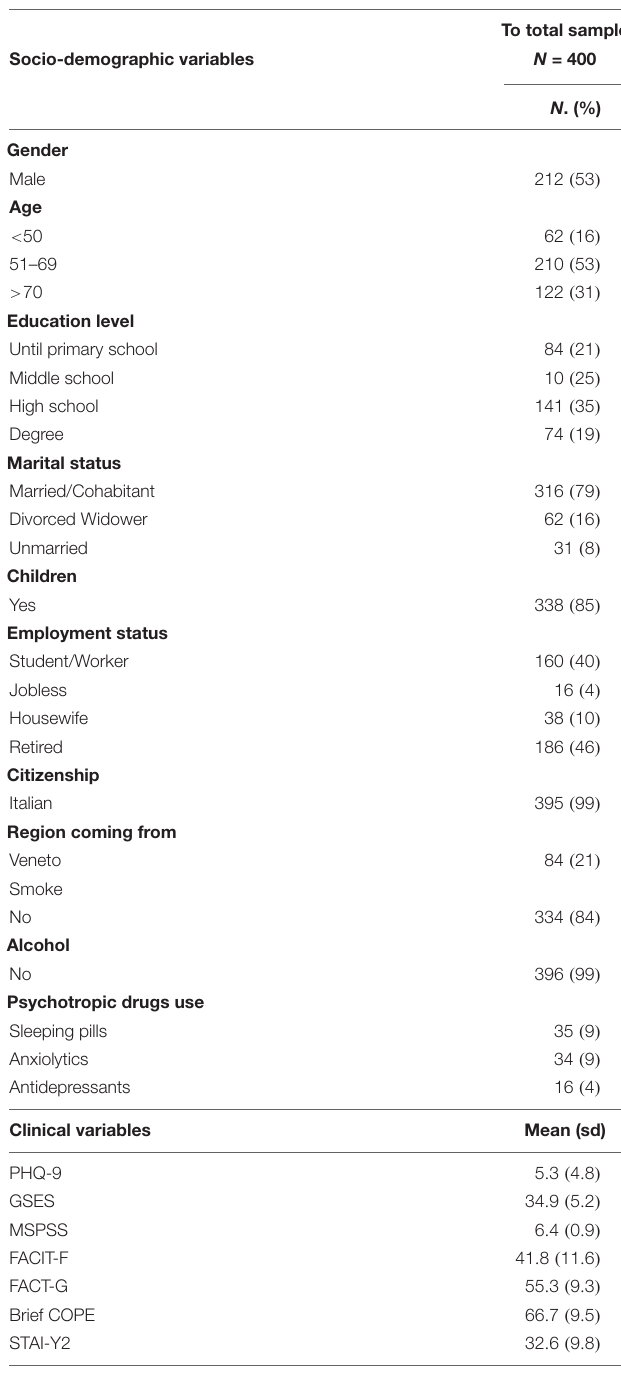
TABLE 2 | Socio-demographic and clinical characteristics of patients included in the study.